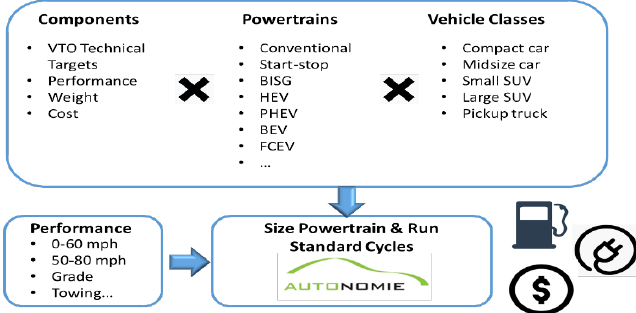
Figure 2. A large scale simulation process to quantify cost-benefits